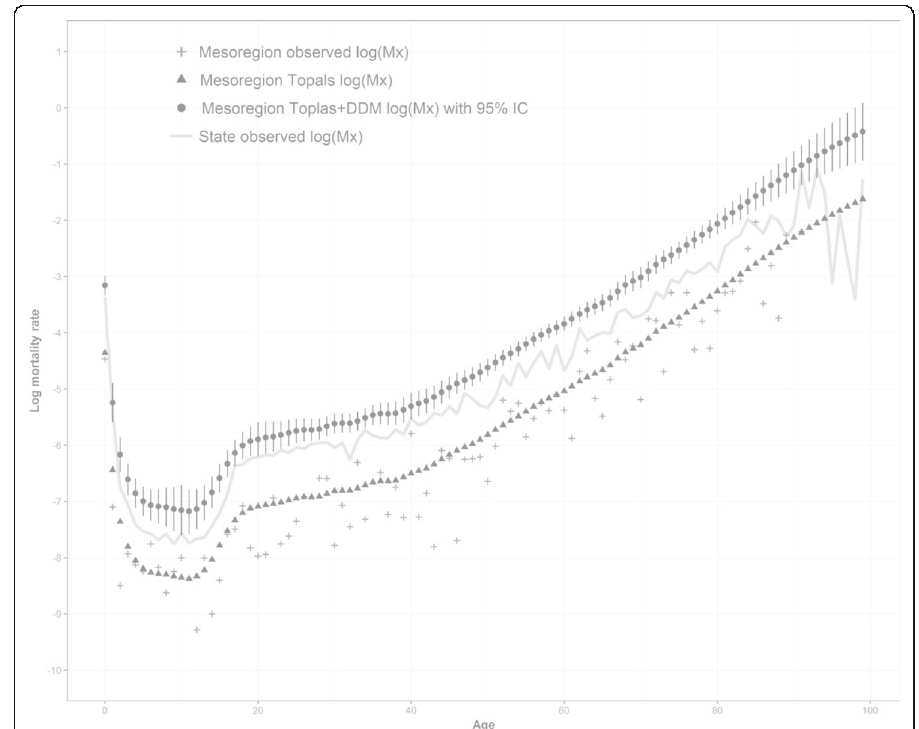
Fig. 2 Observed and smoothed age-specific mortality rates for Mesoregion Southern Amazonas in Brazil, males, 1980 – 1991. Source: IBGE (1980, 1991, and 2000) and DATASUS